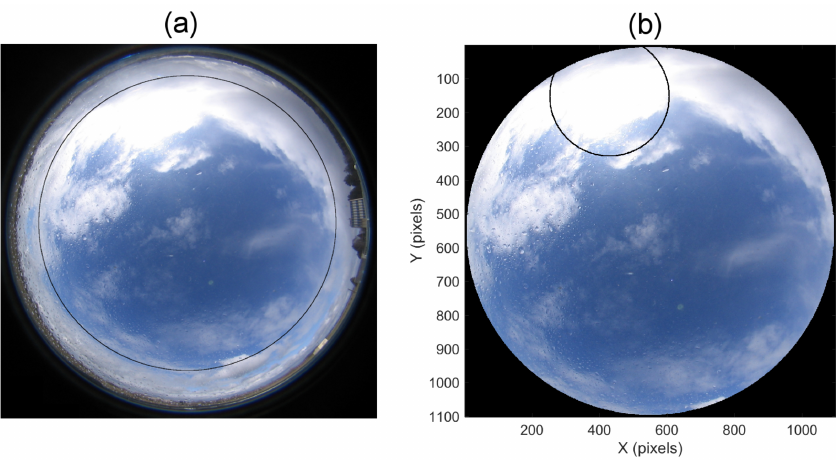
Figure 3. (a) Initial image on 26 February 2014 at 13:00UTC. (b) Corresponding cropped image (step 1 of the process). In (a) , the black circles indicate the contour of the cropped image shown in (b) , outside which the pixels are not processed. In (b) , the black circle indicates the contour of the sun mask, within which the pixels are not